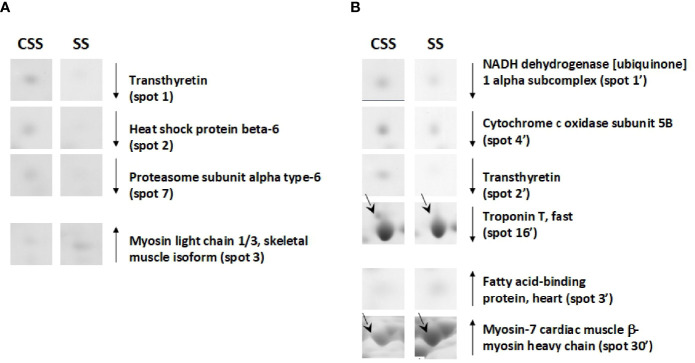
SS–dependent differentially represented proteins in tibialis anterior (A) and soleus (B). Representative subsections of 2D-E images of tibialis anterior and soleus. CSS, control of semi-starved rats; SS, semi-starved rats. A selection of spots is shown. Identified protein spots belong to those showing a relative intensity that differed significantly between experimental groups by at least 2-fold with a p<0.05 (Student’s t-test). Down arrows mean reduced representation; up arrows mean increased representation. Effects of SS are reported vs. CSS. Spot numbering refers to 
Figure 5
 and
Supplementary Data 2
.